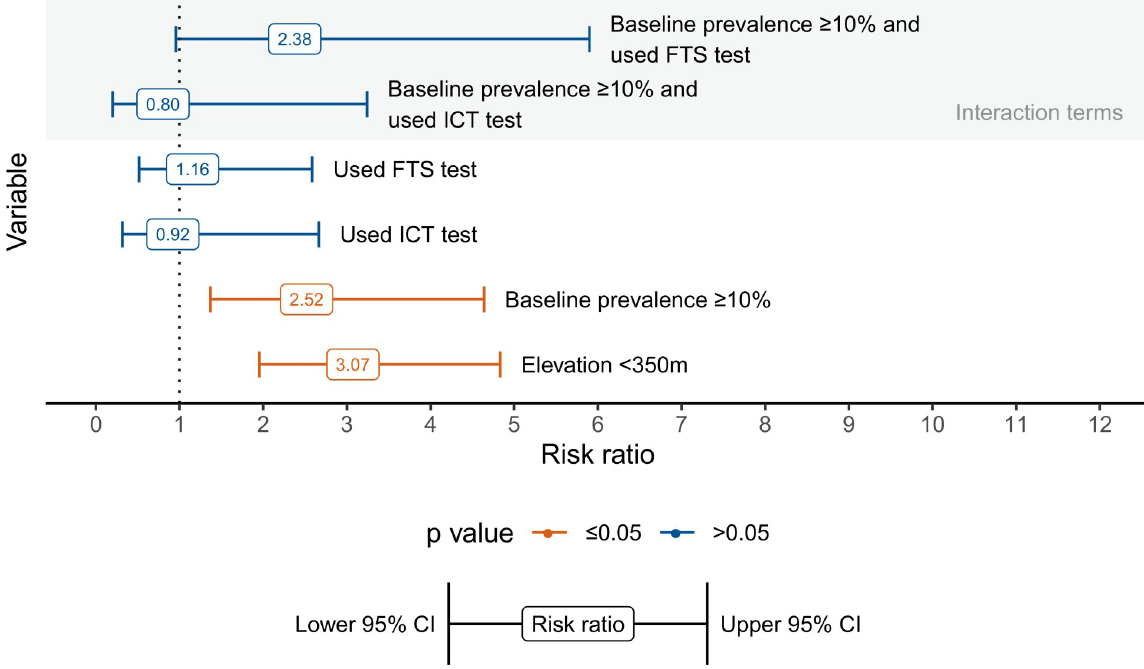
Fig 4. Adjusted risk ratios for pre-TAS failure with 95% Confidence Interval from log-binomial model.